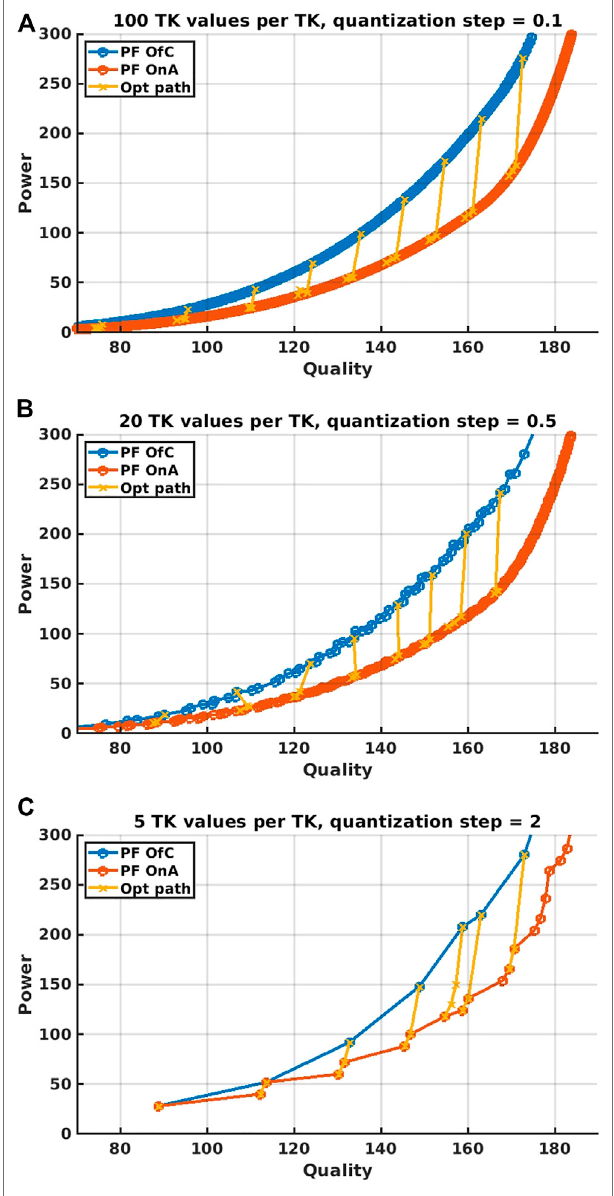
FIGURE 7 | Applying the optimization algorithm of Section 4 to a theoretical use case, with increasing discretization step size.